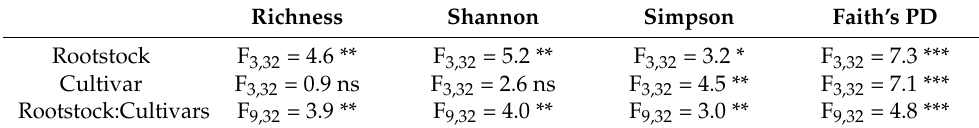
Table 1. ANOVA results of α -diversity measures per rootstock and cultivar identity and the inter- action between the two factors. Data were aligned rank transformed prior to statistical analysis.